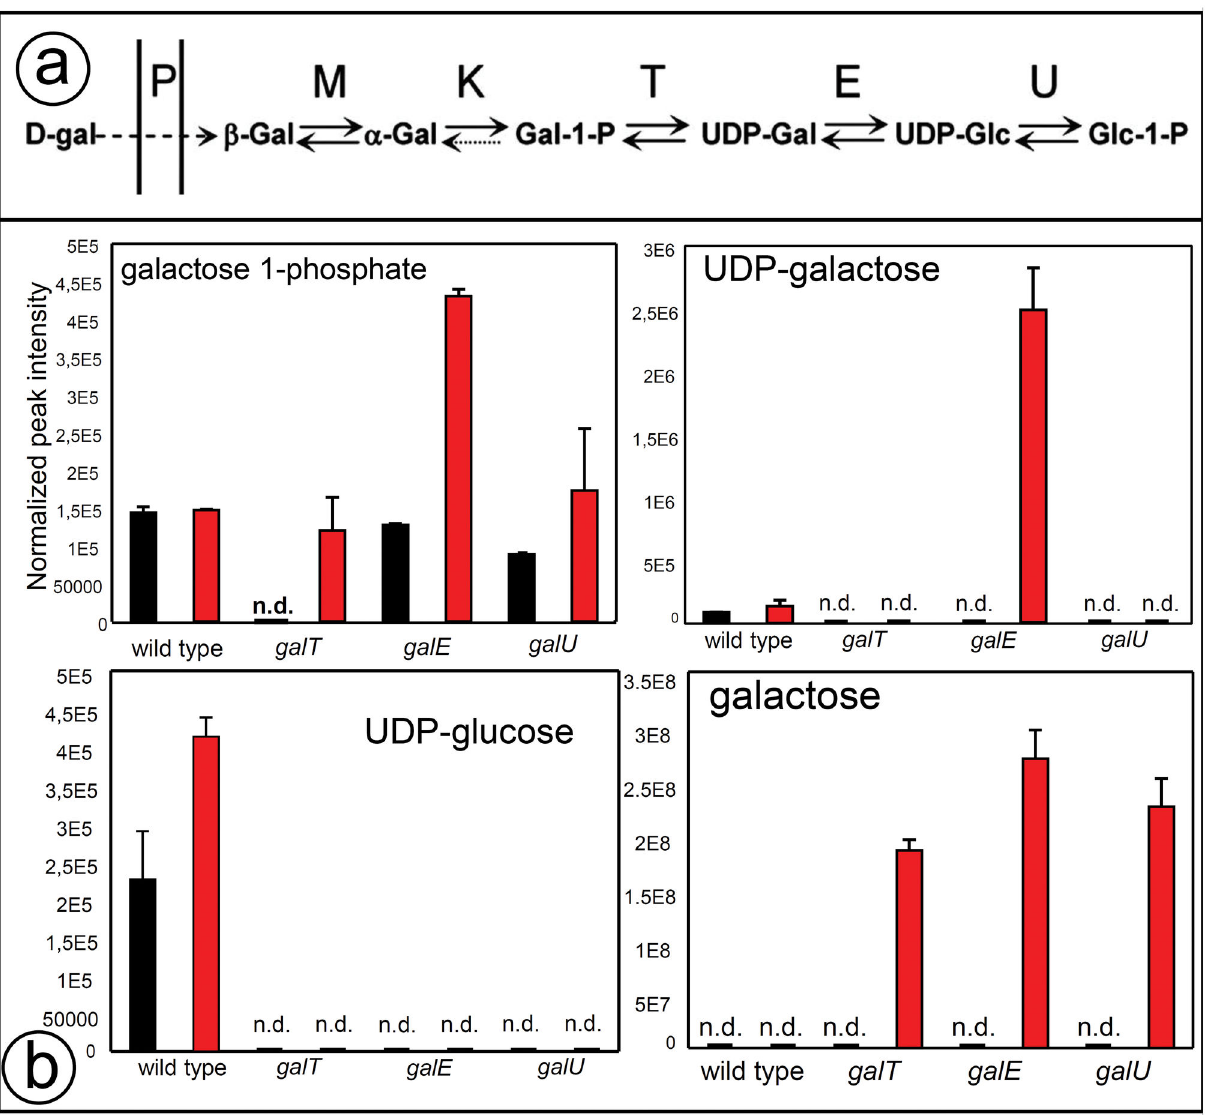
Figure 1. Inactivation of galactose metabolism pathways in E. coli mutants leads to disturbed levels of intermediates. (a) Upper panel shows the Leloir pathway in E. coli for the metabolism of galactose. (b) Lower panel shows the levels of intermediates in the pathways in wild-type and galT, galE and galU mutants. n=3 (biological